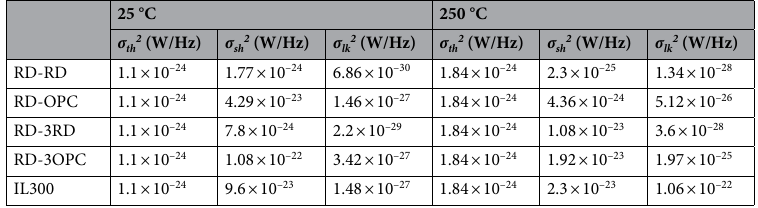
Table 7. Noise components of the optocouplers at 25 °C and 250 °C.